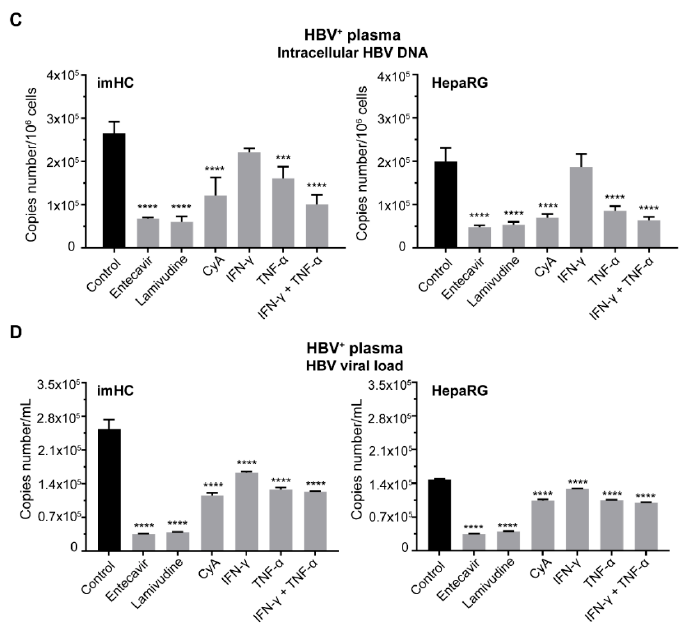
Figure 5. The response to direct-acting antiviral drugs (DAAs) and antiviral cytokines in infected host cells. Both the imHC and HepaRG were infected with either HBVcc ( A , B ) or HBV + plasma ( C , D ) and treated with DAAs such as entecavir, lamivudine, lamivudine, CyA including antiviral cytokines (IFN- γ , TNF- α ). The alteration in intracellular HBV DNA in response to antiviral agents